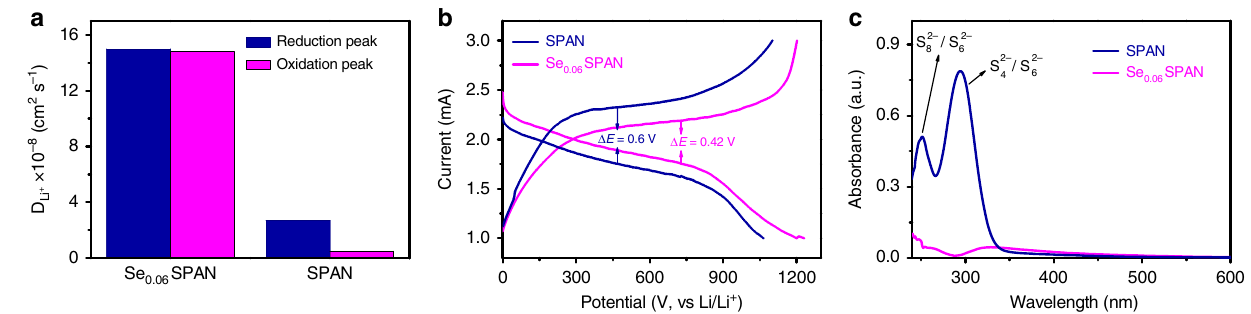
Fig. 5 Improved electrochemical reaction kinetics. a Li + diffusion coef fi cients of reduction peak of Se 0.06 SPAN and SPAN cathodes. b Discharge – charge curves of SPAN and Se 0.06 SPAN electrodes. c UV – Vis absorption spectra of the solution after washing cycled SPAN and Se 0.06 SPAN cathodes